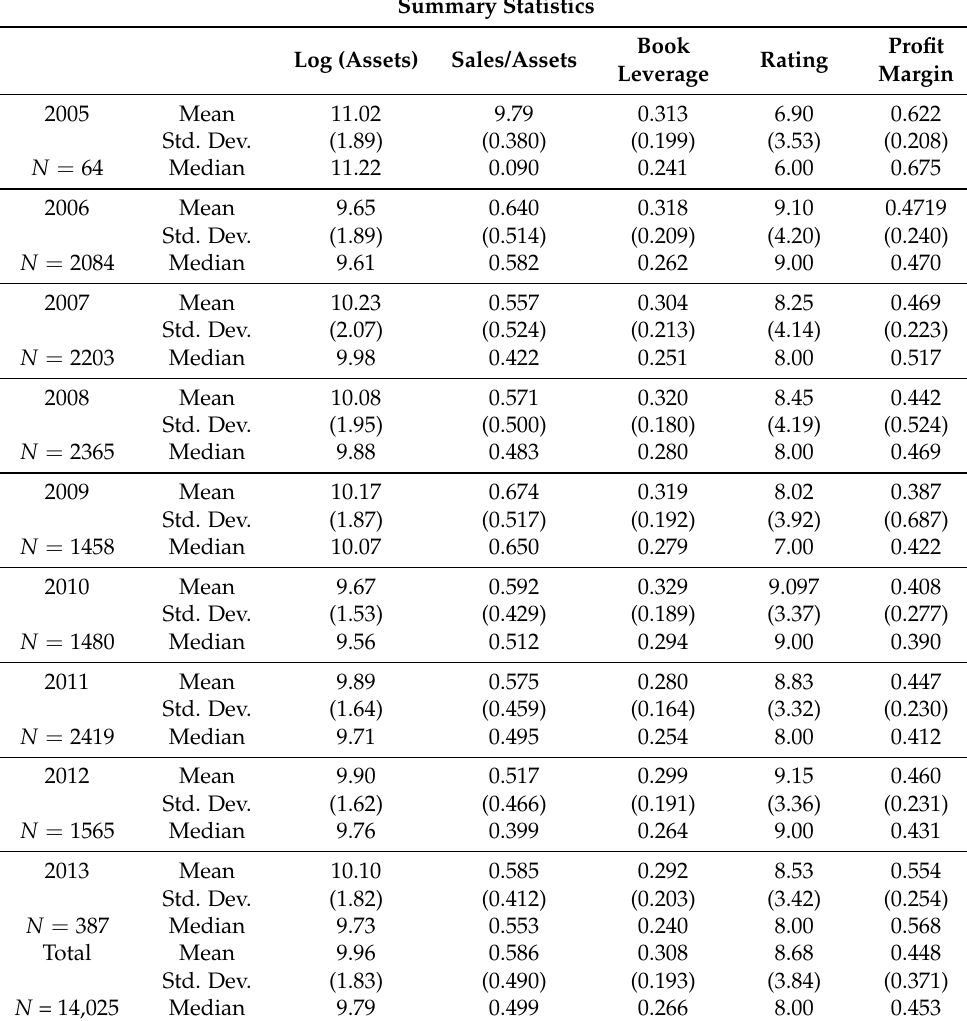
Table 2. Peer Firms’ Summary